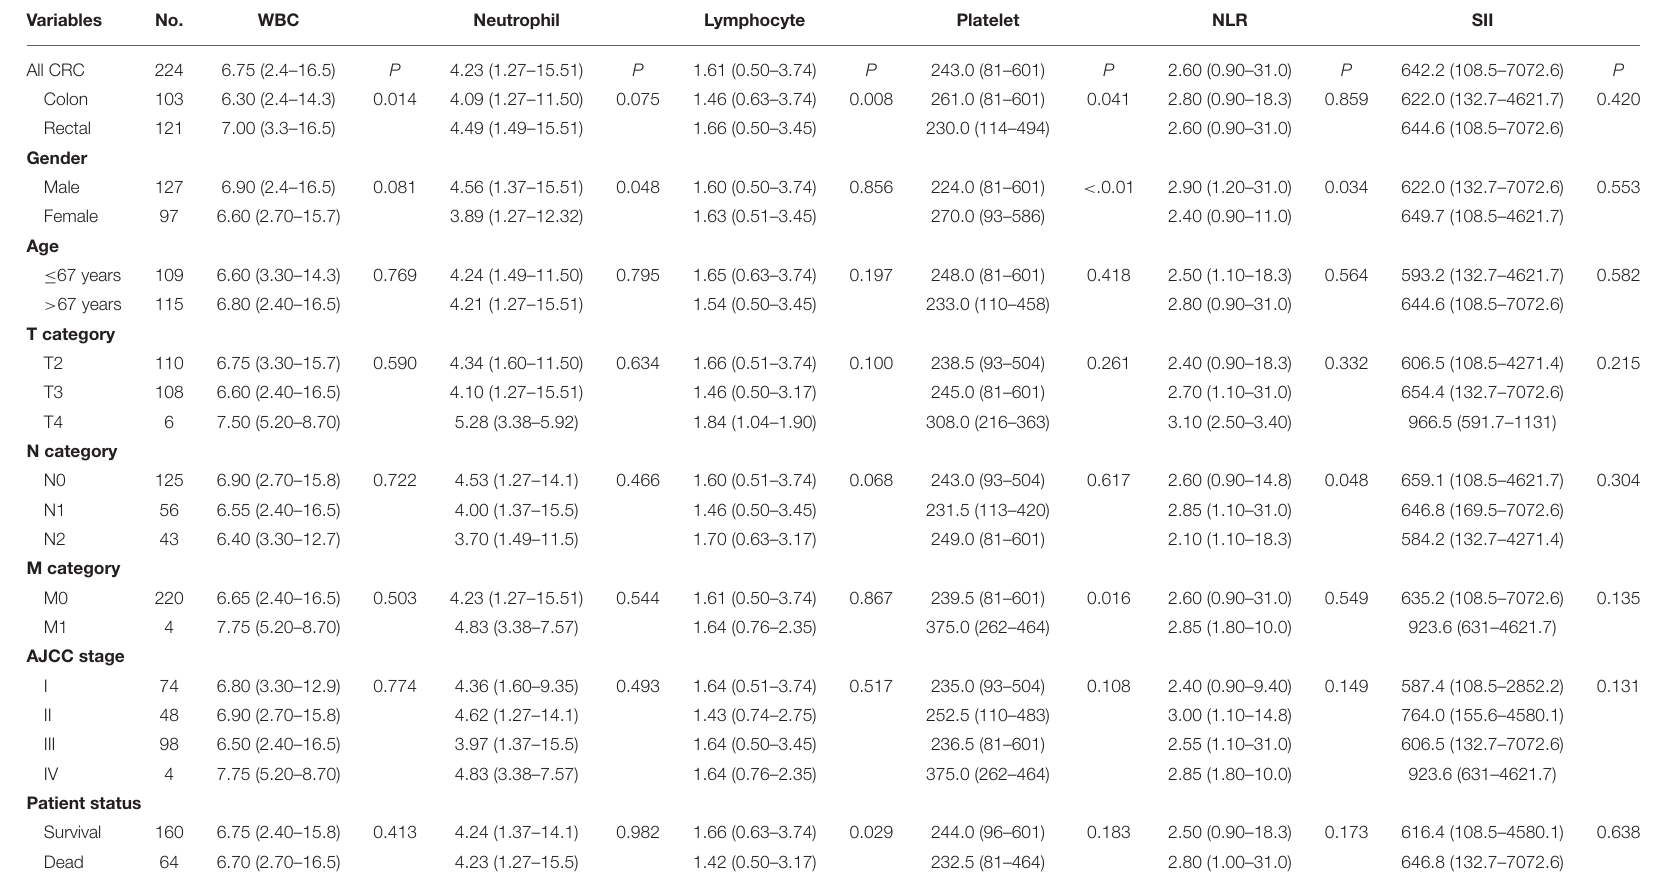
TABLE 1 | Pre-operation laboratory data and their association with clinicopathological parameters in CRC patients*.